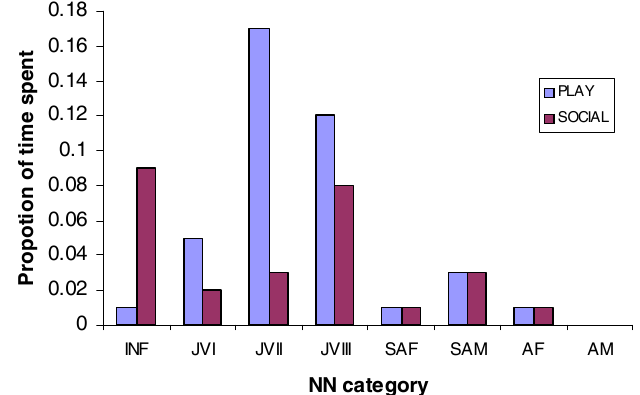
Figure 5. Proportions of time spent for social play (Play) and non-play social (Social) contacts by the juvenile elephants with each NN category. (Symbols as in text)